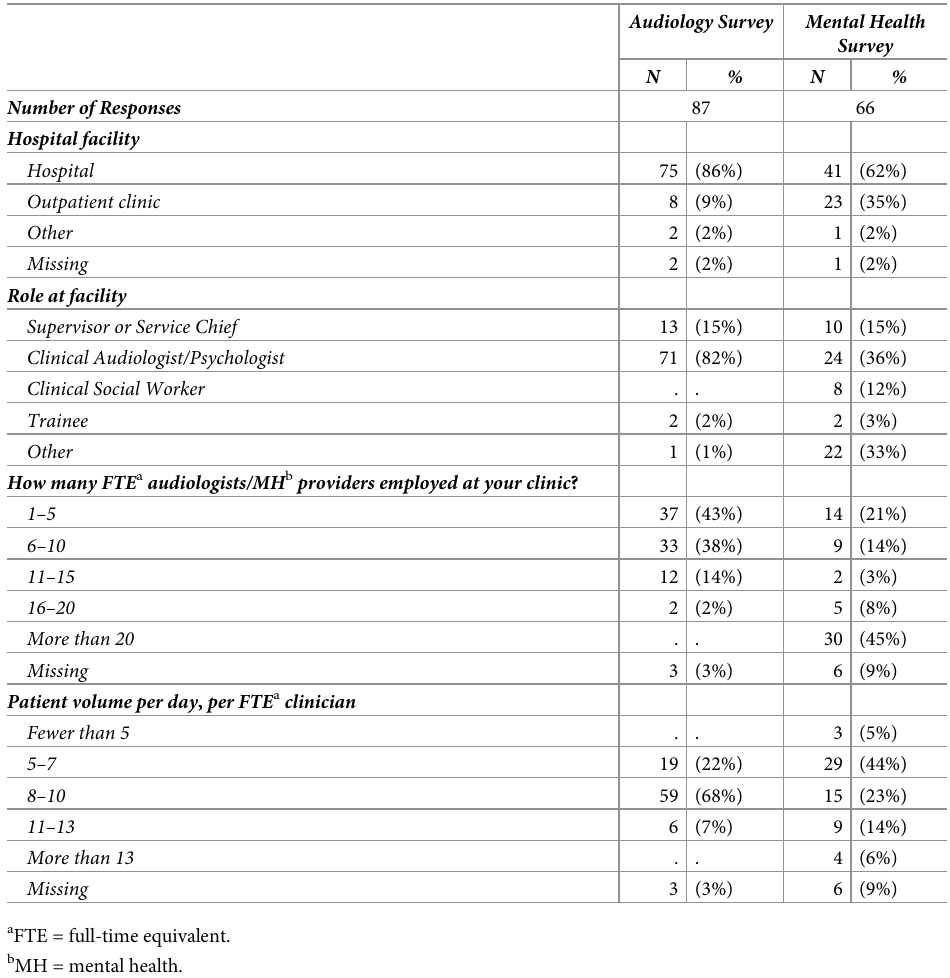
Table 1. Descriptive characteristics of survey